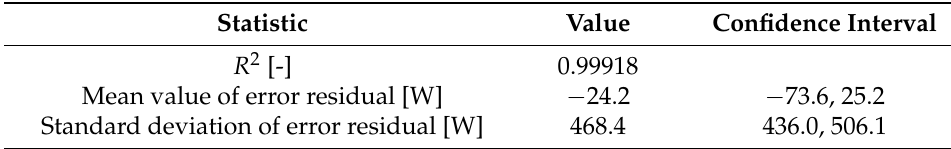
Table 1. Statistics from the electric motor model